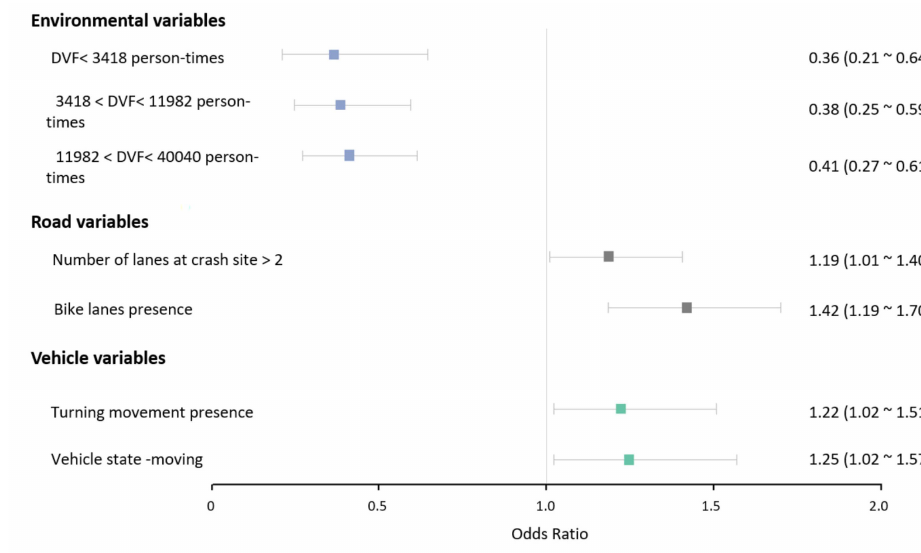
Figure 4. Odds Ratio of the influencing factors for crash severity in the conventional mode. Table 3. The hierarchical Bayesian model for crash severity in the autonomous